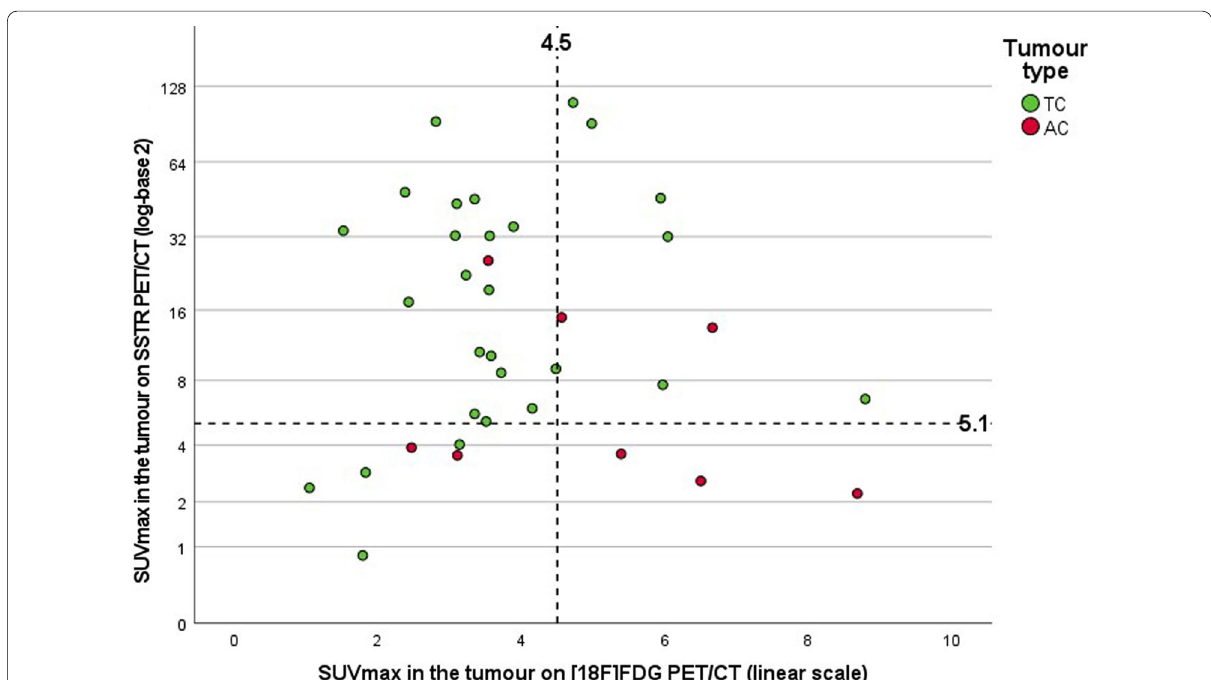
Fig. 2 Scatter plot of the paired SUV max values on SSTR PET/CT and [ 18 F]FDG PET/CT scans for typical (TC) and atypical (AC) bronchial carcinoid tumours (n 36), with dashed reference lines on the cut‑off SUV max values (5.1 for SSTR PET/CT and 4.5 for [ 18 F]FDG PET/CT) based on the maximal = Youden’s index derived from the ROC curves of the non‑paired SUV max values on SSTR and [ 18 F]FDG PET/CT scans for TC and AC, respectively